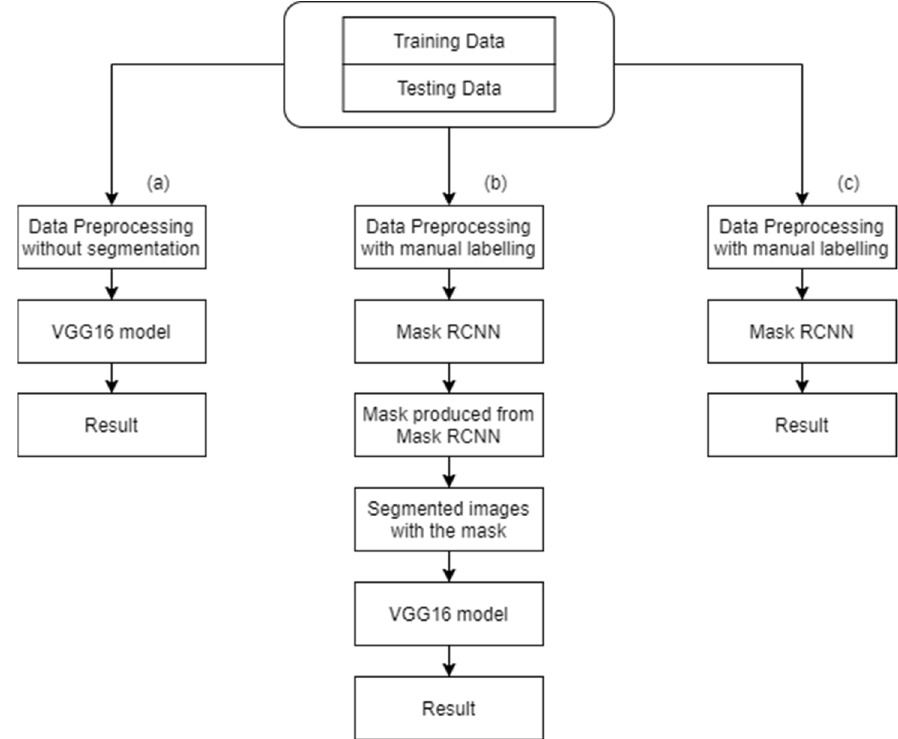
Figure 8. Workflow of each classification model. ( a ) VGG16 model trained with unsegmented images, ( b ) VGG16 trained with segmented images produced by Mask RCNN, ( c ) Mask RCNN trained with manually labelled images.